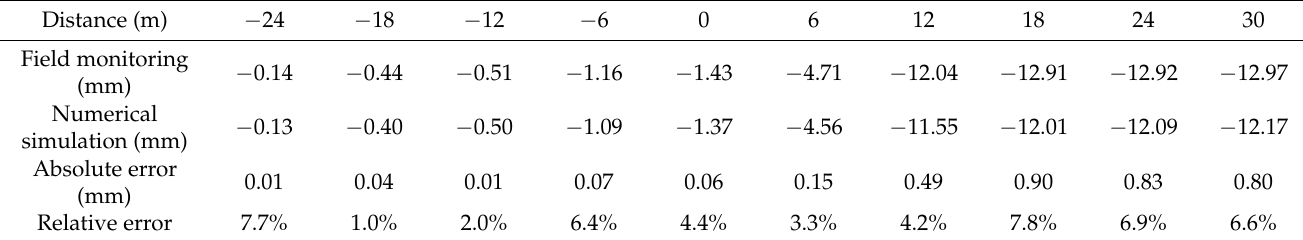
Table 3. Longitudinal surface displacements of A 11 and hole 2 #.